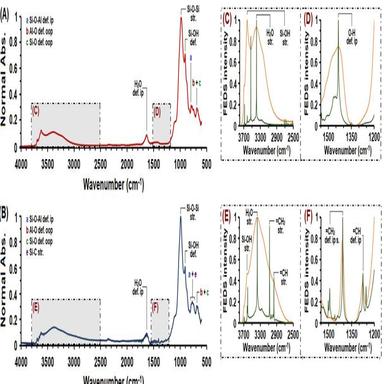
IR-ATR spectra of bentonite (A) and CM-Bent (B), as well as, corresponding FEDS spectrum (C–F).